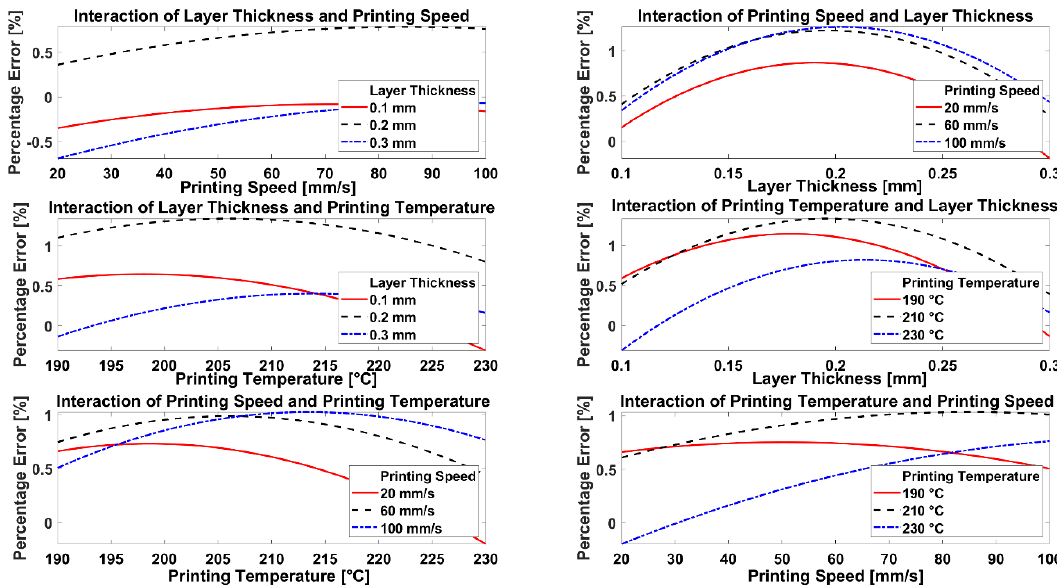
Figure 9. Effects of interaction of parameters on measured percentage error for 10 mm length in Z direction.